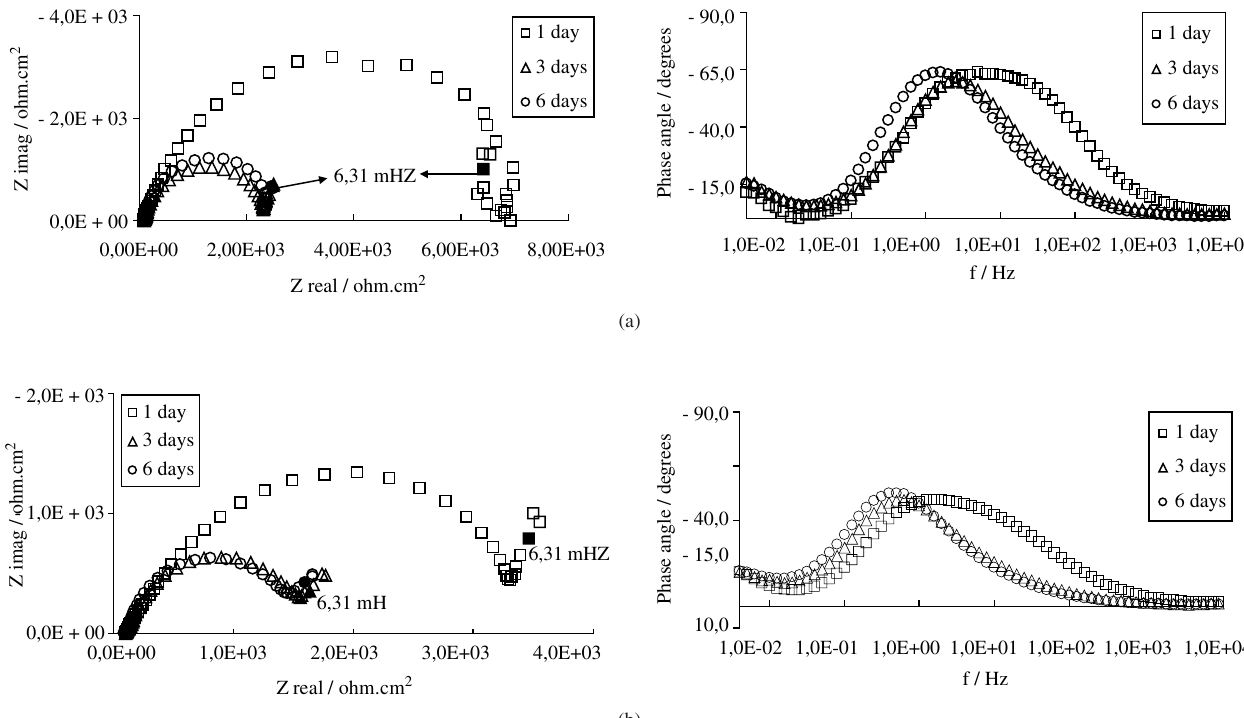
Figure 2. EIS results for hypereutectic Al-Si-Cu alloys in naturally aerated CSAS at increasing immersion periods, showing Nyquist and Bode phase diagrams for: a) alloy 3; b) alloy